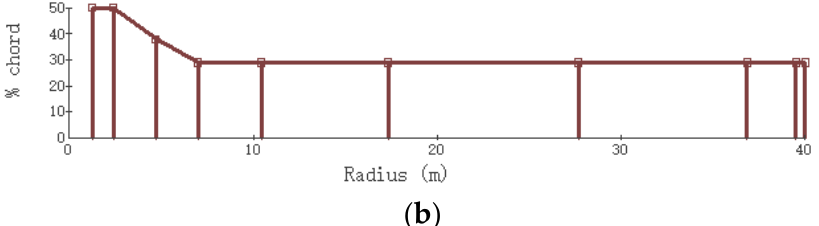
Figure A1. Blade information: ( a ) blade geometry; ( b ) mass and stiffness of blade.